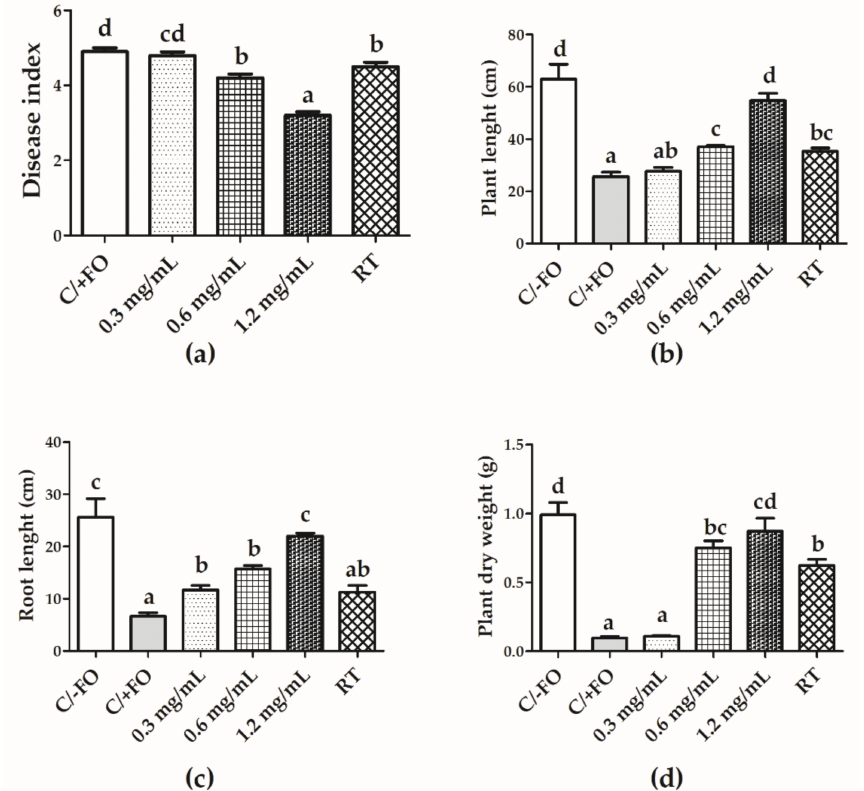
Figure 6. Effect of tomato seed treatment with different concentrations (0.3, 0.6, and 1.2 mg/mL) of Jania adhaerens water-soluble polysaccharides on the disease index ( a ), plant and root length ( b , c ) and plant dry weight ( d ) in a growth substrate infected with Fusarium oxysporum (FO). C/-FO = non infected control; C/+FO = infected control; RT = reference treatment (2 mL/L). Columns are mean values of 3 independent experiments ( n = 3) ± SD. Different letters indicate significant differences among treatments and controls according to the LSD test ( p <